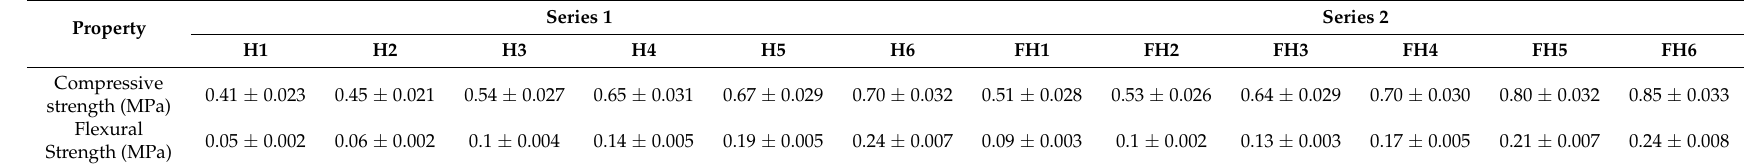
Table 3. Mechanical properties of composites (average value ±